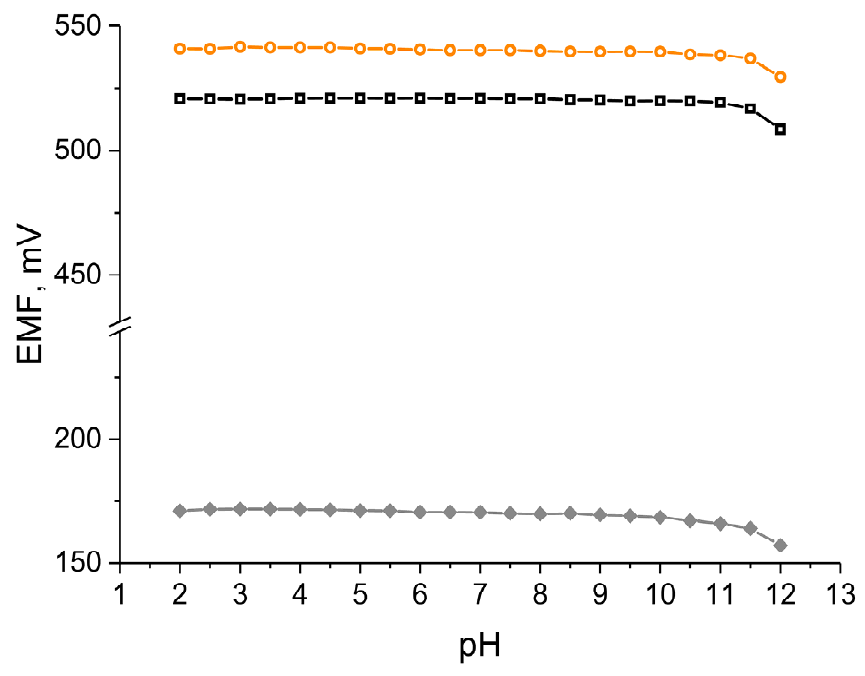
Figure 7. Potentiometric response recorded for GCD/K + -ISM ( (cid:7) ), GCD/hCeO 2 + NTs/K + -ISM ( □ ) and GCD/hCeO 2 + POT/K + -ISM ( ○ ) electrode during the pH test.